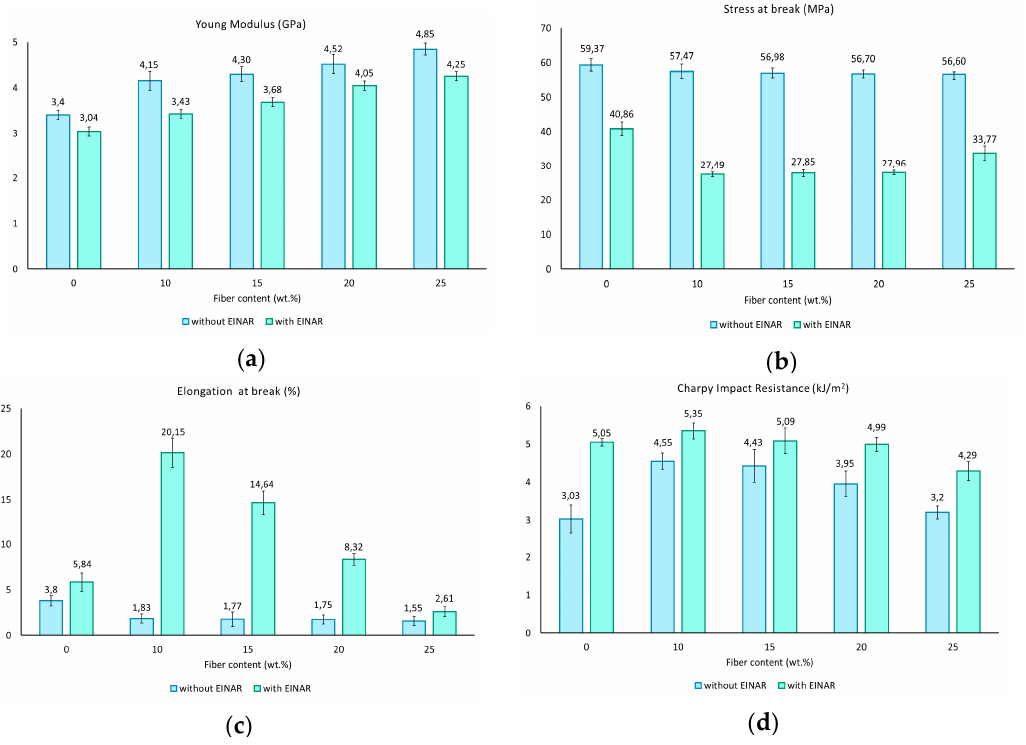
Figure 2. Mechanical properties for the two PLA / Arbocel composite systems: ( a ) Young modulus, ( b ) stress at break, ( c ) elongation at break, ( d ) Charpy impact resistance.